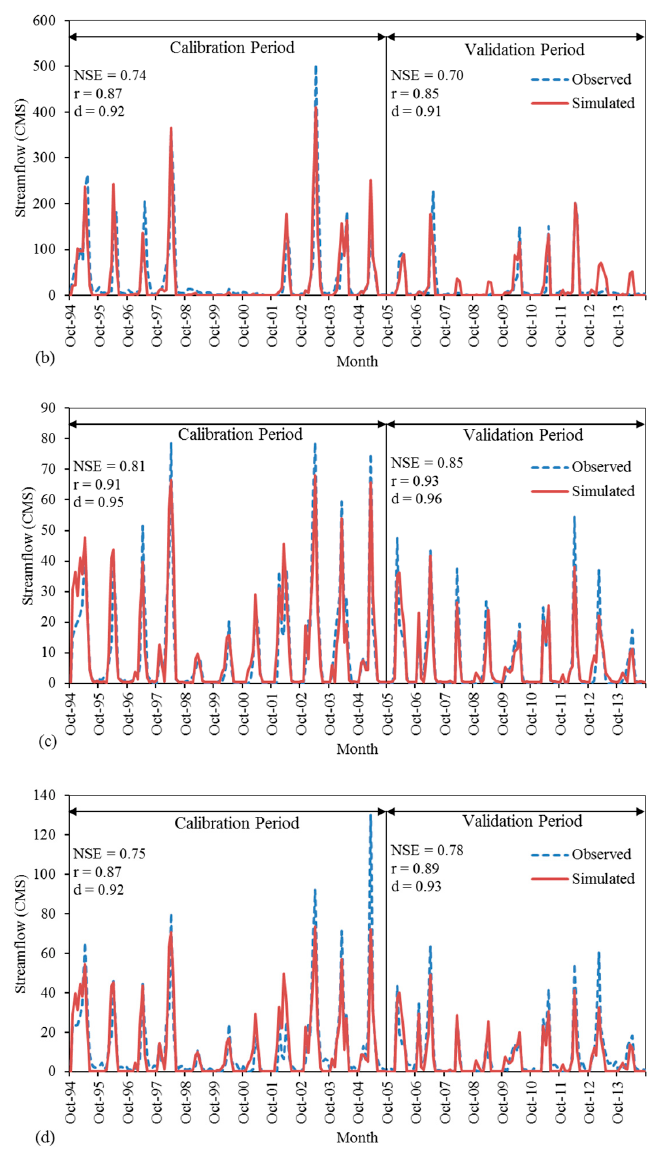
Figure 4. Observational and simulated monthly discharges for calibration and validation periods at hydrometry stations: ( a ) entrance of Boukan Dam; ( b ) Nezam Abad; ( c ) Dashband; and ( d ) Miandoab Bridge.